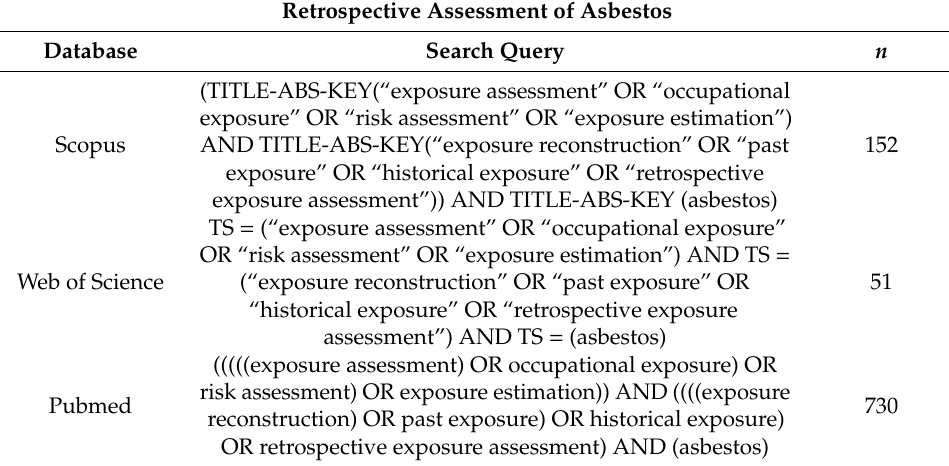
Table 2. Query used for REA studies dealing with asbestos. N: number of papers results from the search. Date of search: 18 May